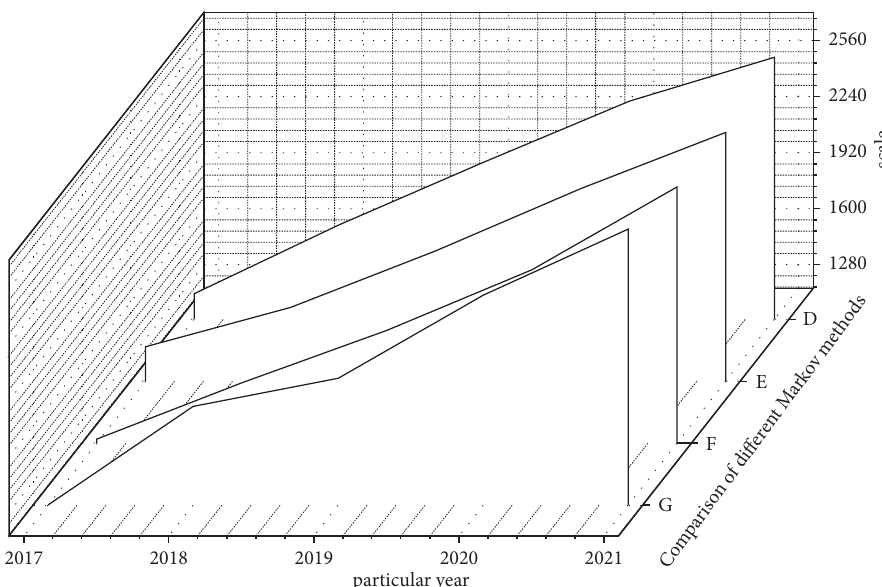
Figure 6: Results of various processing methods of Markov model in different years.